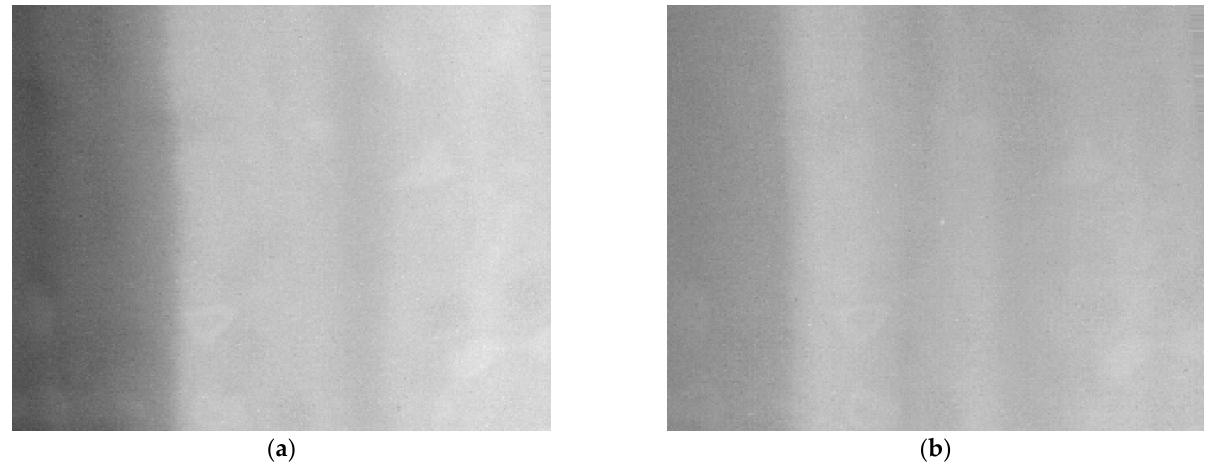
Figure 19. Flight experiment of detecting small and weak target without filter. ( a ) clouds and skyline; ( b ) close-range non-cooperative goals.